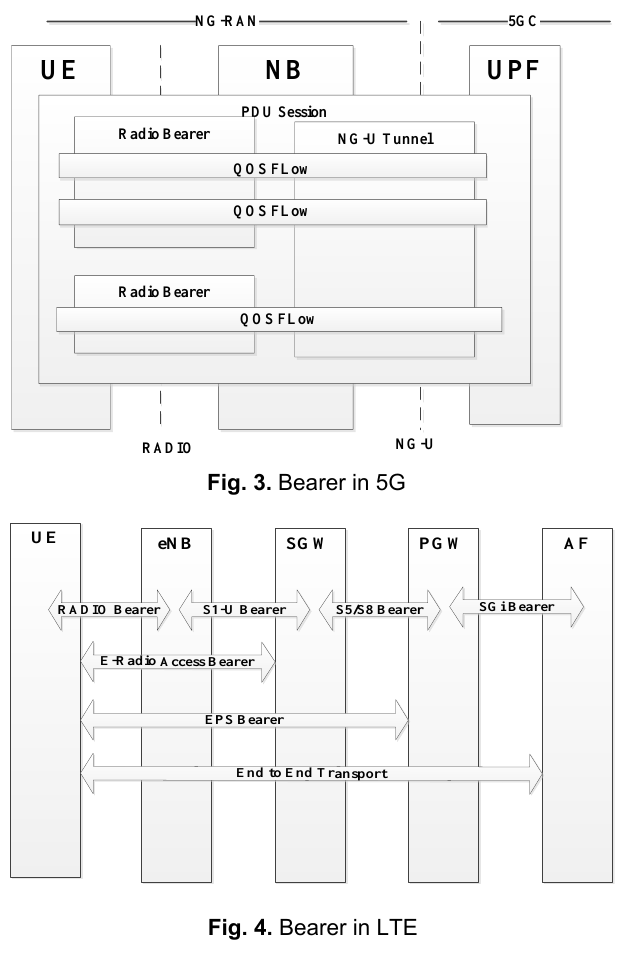
Fig. 4. Bearer in LTE